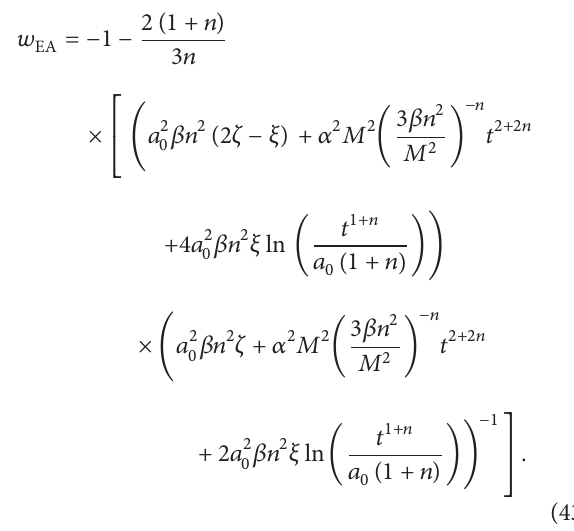
Figure 3: ((a) and (b)) The variations of 𝑤 represents type II